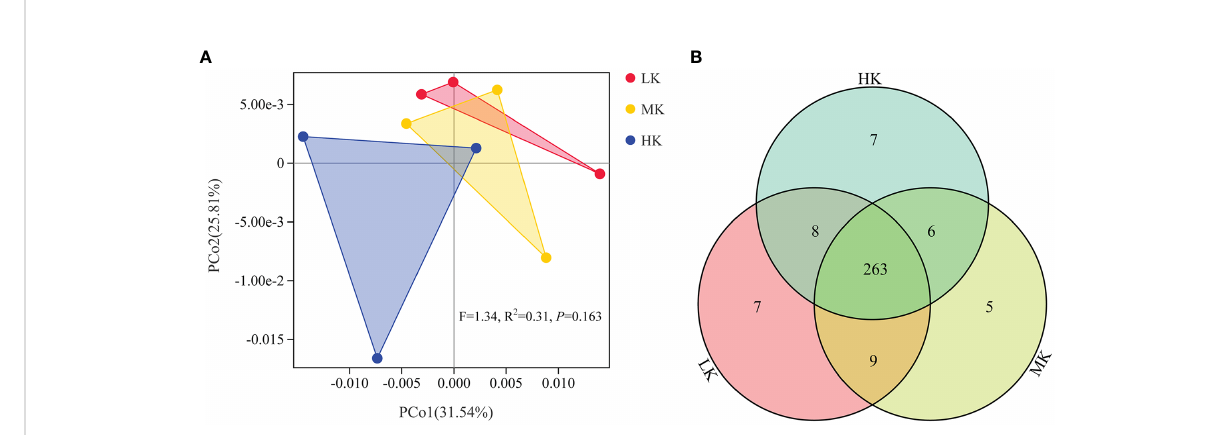
FIGURE 6 Similarity and differentiation of KEGG pathways with different fertilization treatments. (A) PCoA plot of KEGG pathways at level 3; (B) Venn diagram of exclusive and shared KEGG pathways at level 3. LK, Low amount of K 2 SO 4 ; MK, Middle amount of K 2 SO 4 ; HK, High amount of K 2 SO 4